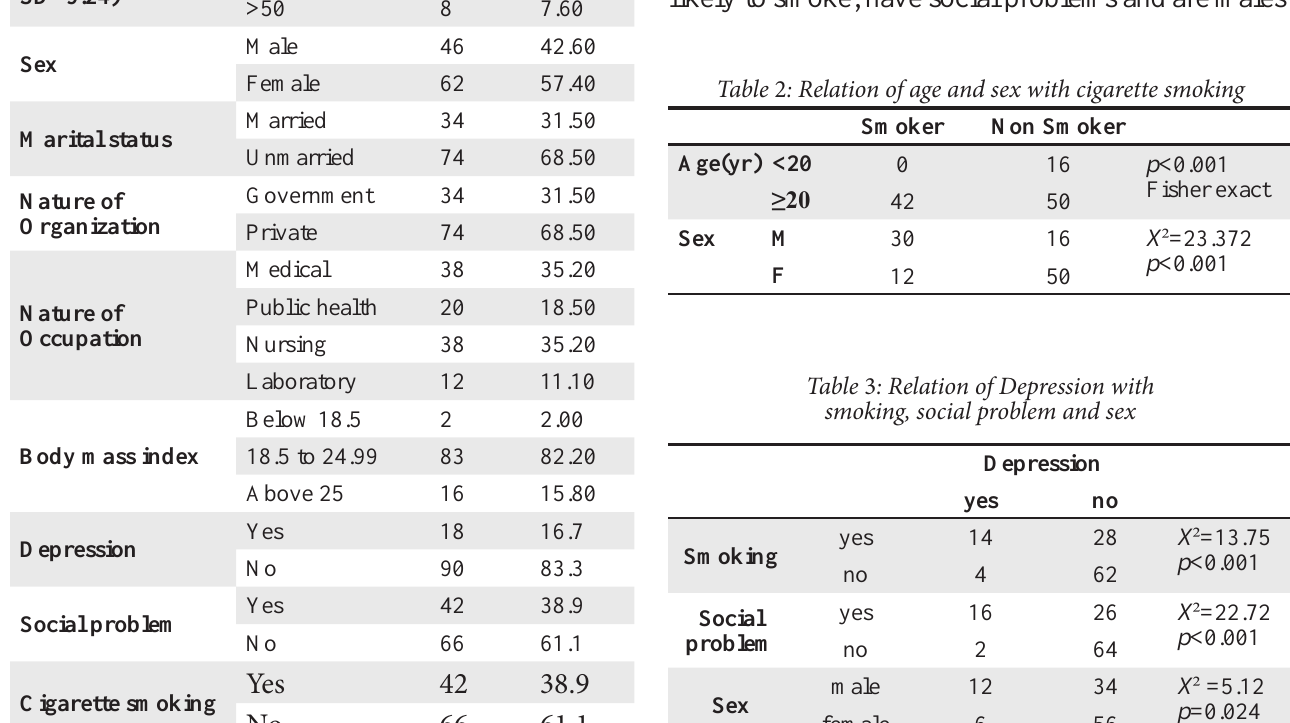
Table 1 : Demographic profile of respondents (N=108). Variables N % Age in years (M = 27.35,